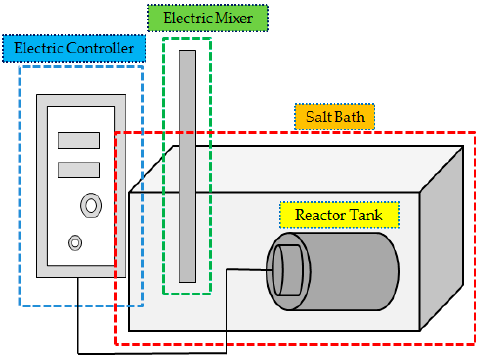
Figure 2. In-house-built salt bath reaction device and reactor tank.